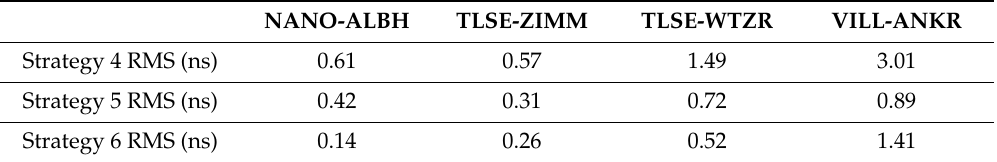
Table 5. The clock di ff erence RMS of 7 days before and after phase smoothed.